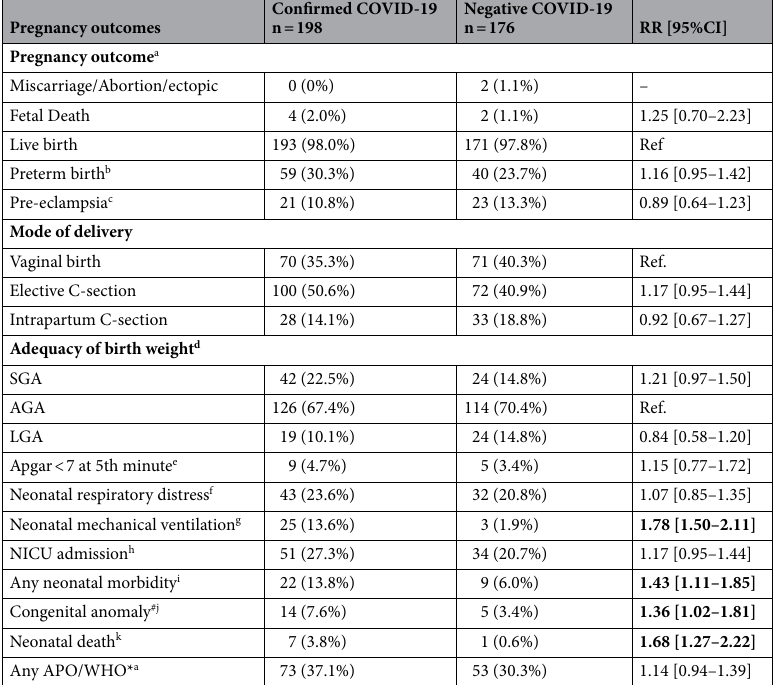
Table 3. Risk estimates for adverse pregnancy outcomes according to COVID-19 infection status in pregnant women (n = 374). Missing information for a 2, b 10, c 7, d 25, e 35, f 38, g 28, h 23, i 66, j 41, k 24. *APO: NICU admission, preterm birth, fetal death, neonatal death, miscarriage/abortion. # From the 19 cases of congenital anomaly. 6 were tested for SARS-CoV-2 neonatal infection; all were negative. Significant values are in